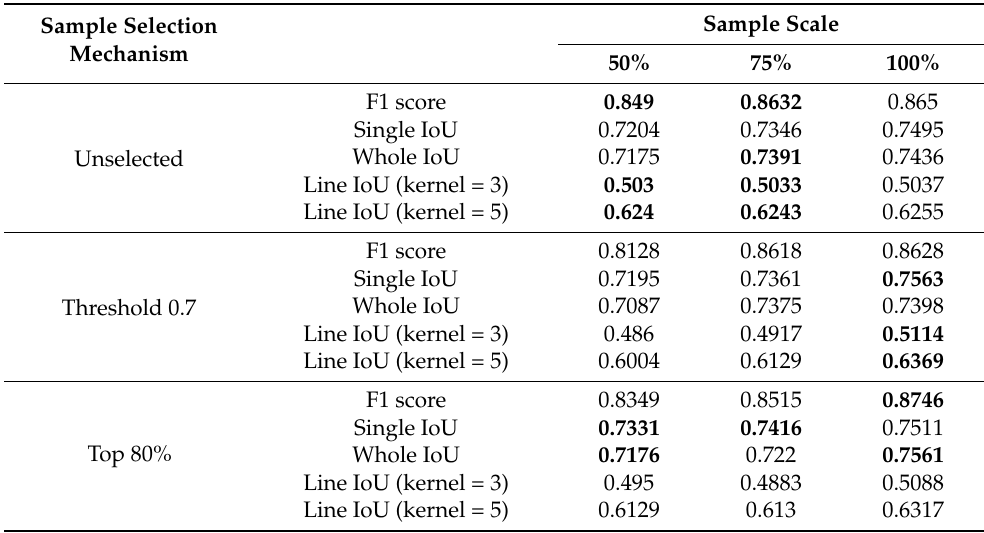
Table 4. Precision evaluation results for sample selection mechanism analysis in the semi-supervised method. 50%, 75% and 100% are the scale of manually labeled samples. The sample selection method calculates the ratio of the complete boundary in prediction results to the real boundary to select higher-quality pseudo-labels. Unselected means all the pseudo-labels participate in training without selection. Threshold 0.7 means the method sets a threshold of 0.7 to remove incomplete samples. Top 80% means the top 80% of pseudo-labels with the highest ratio will be used for training.